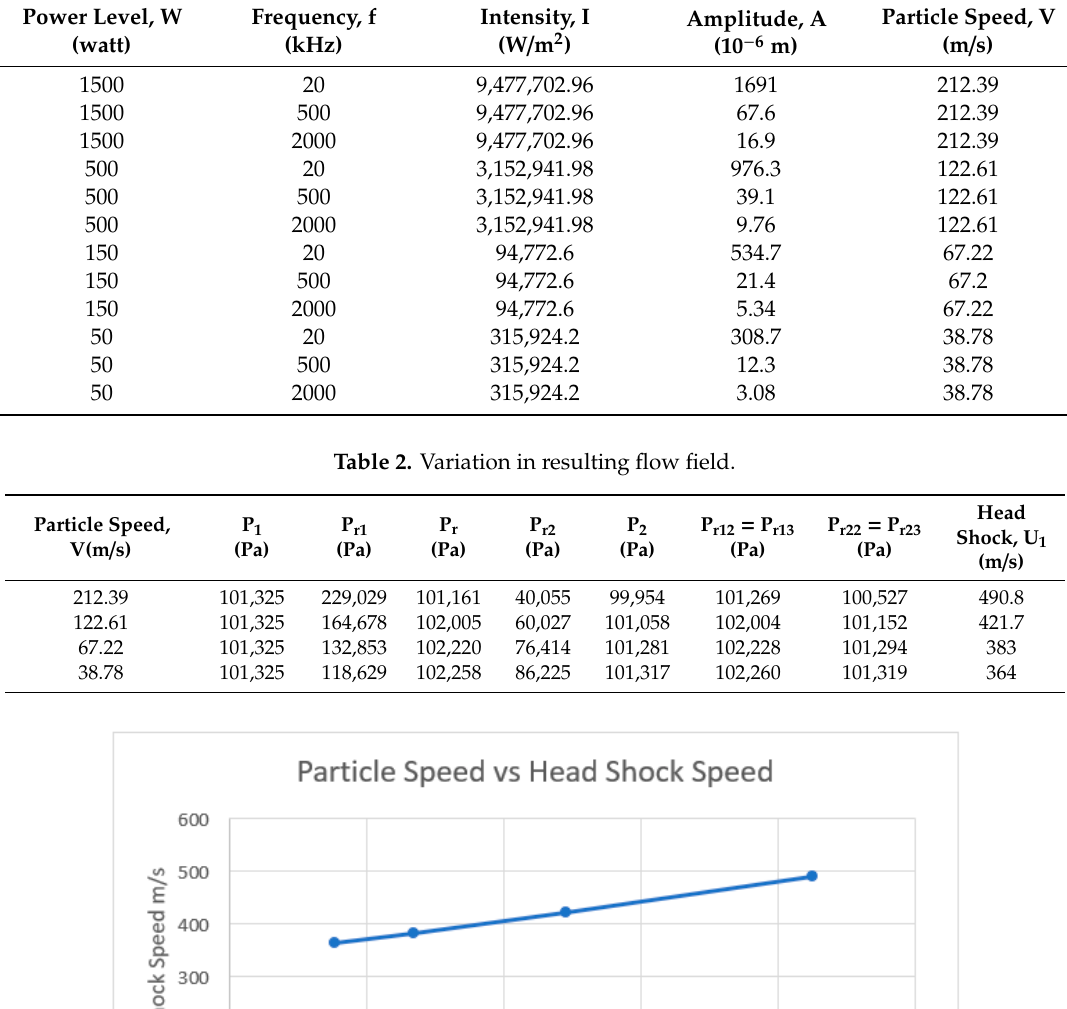
Table 1. Vibration speed of fluid particle in acoustic field of varying power level and frequency.